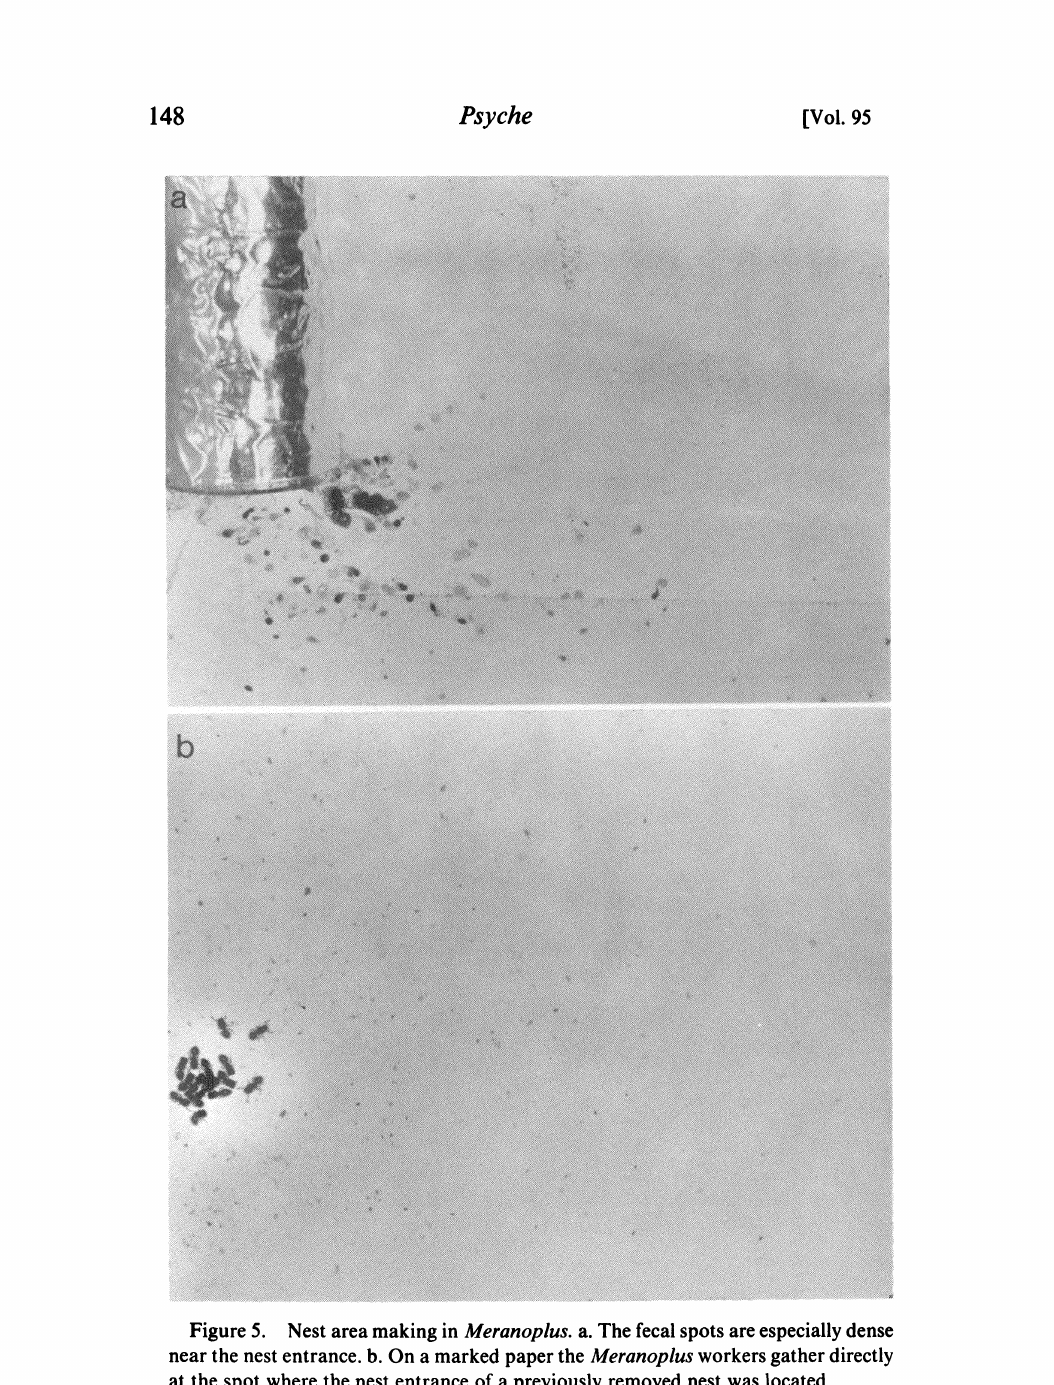
Figure 5. Nest area making in Meranoplus. a. The fecal spots are especially dense near the nest entrance, b. On a marked paper the Meranoplus workers gather directly at the spot where the nest entrance of a previously removed nest was